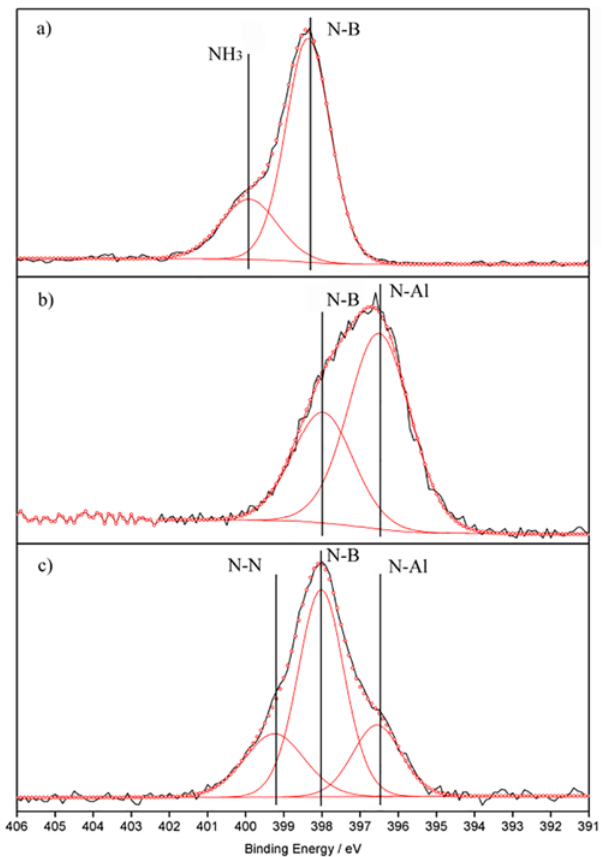
Figure 4. The N 1s XPS results of Al(NH 2 BH 3 ) 3 ·3NH 3 ( 1 ) before ( a ) and after thermal decomposition in an open system ( b ) and in a closed system ( c ). The experiment data are in black, while the fitted ones are in